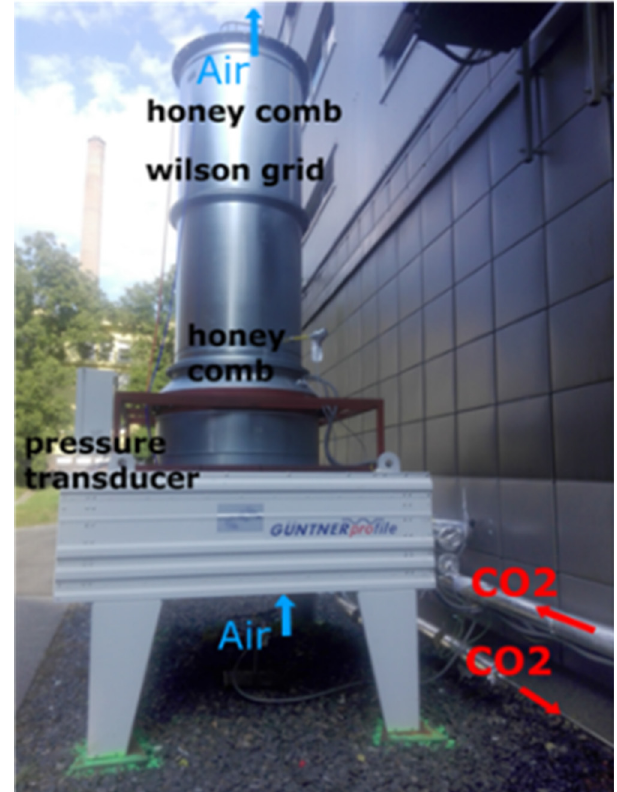
Fig. 8. sCO 2 -HeRo heat rejection unit during test at UJV,